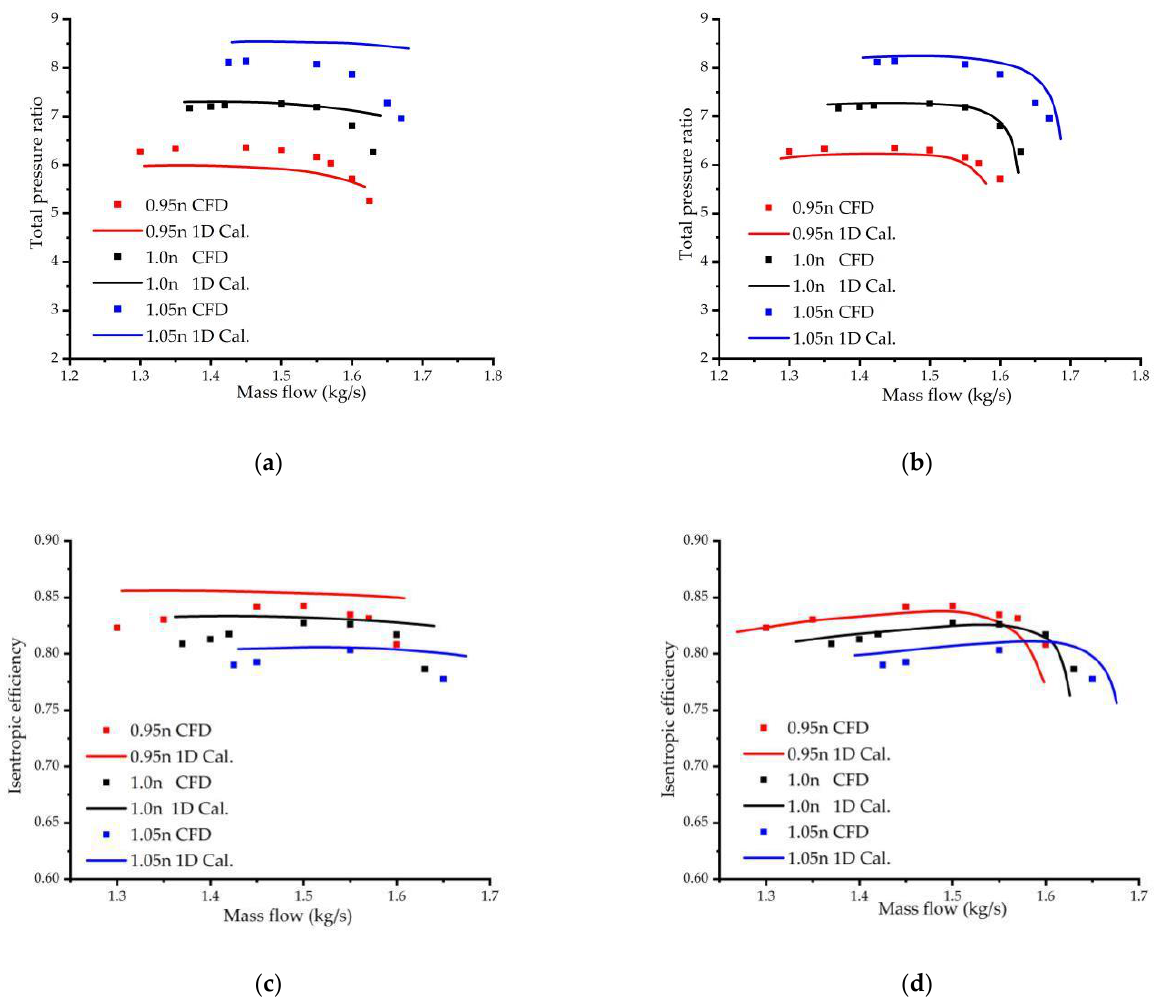
Figure 16. Comparisons of the 1D predicted performance before and after optimization for the impeller J: ( a ) Total pressure ratio before optimization; ( b ) Total pressure ratio after optimization; ( c ) Efficiency before optimization; ( d ) Efficiency after optimization. Table 4. Values for coefficients of the loss models’ set after